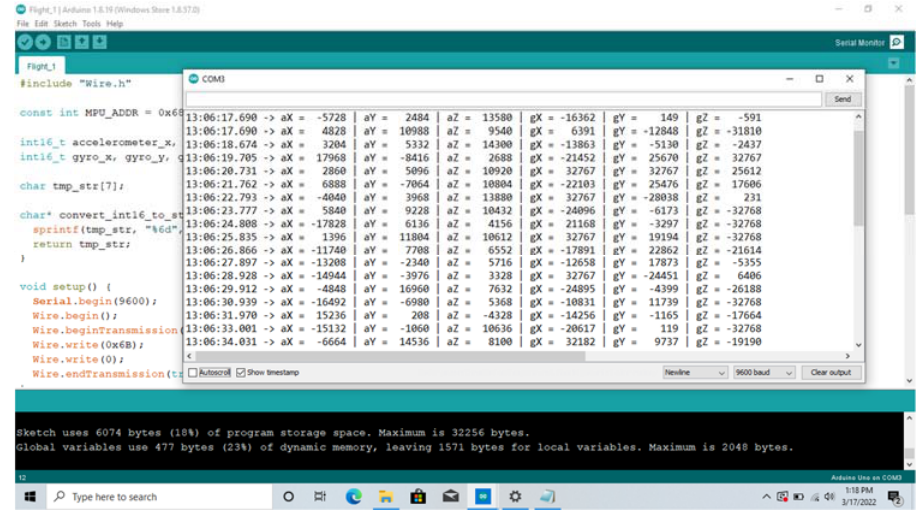
Figure 7. Running the Program in